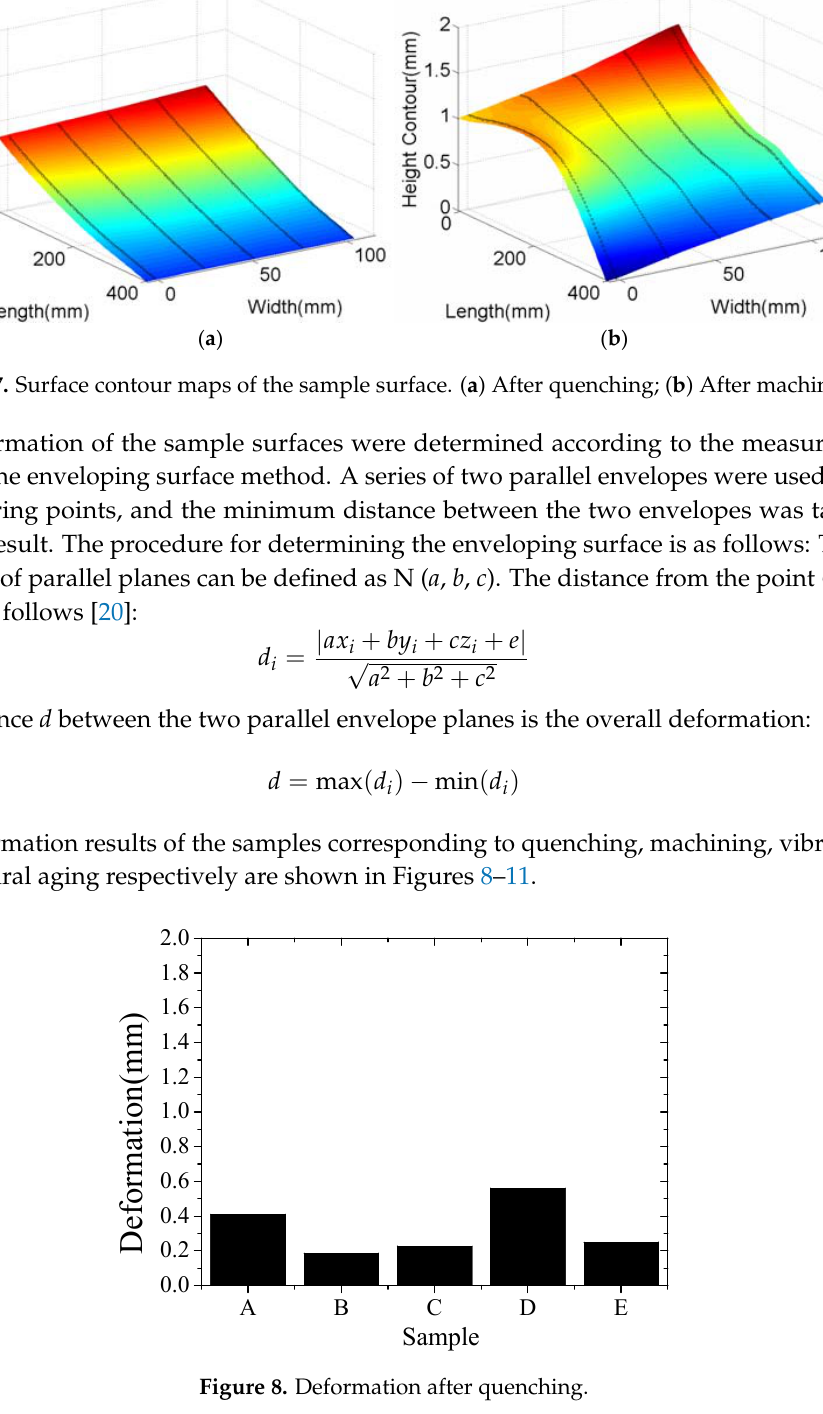
Figure 8. Deformation after quenching.